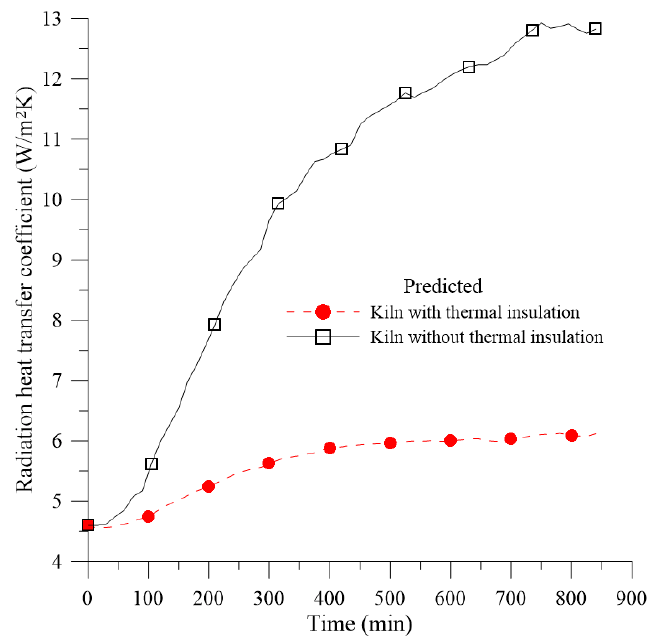
Figure 24. Radiation heat transfer coefficients for the kiln with and without thermal insulation as a function of time.